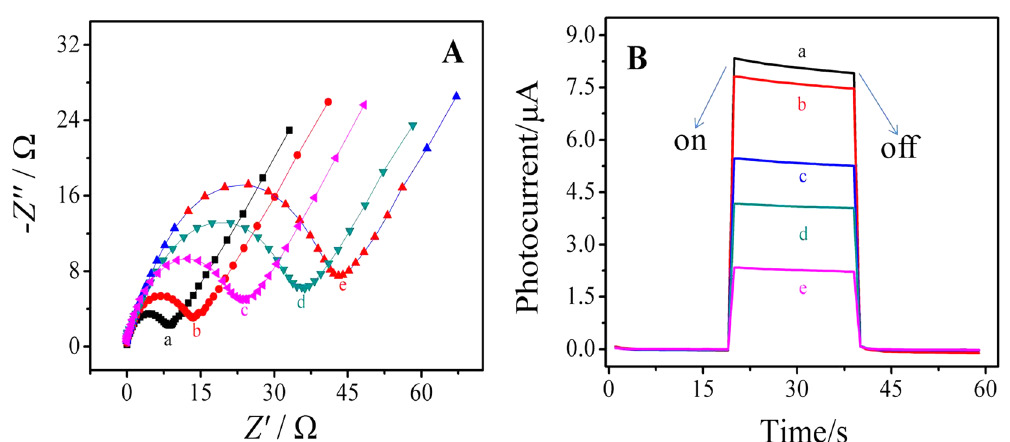
Figure 3. ( A ) Electrochemical impedance Nyquist plot and ( B ) corresponding photocurrent of the modified electrodes: (a)